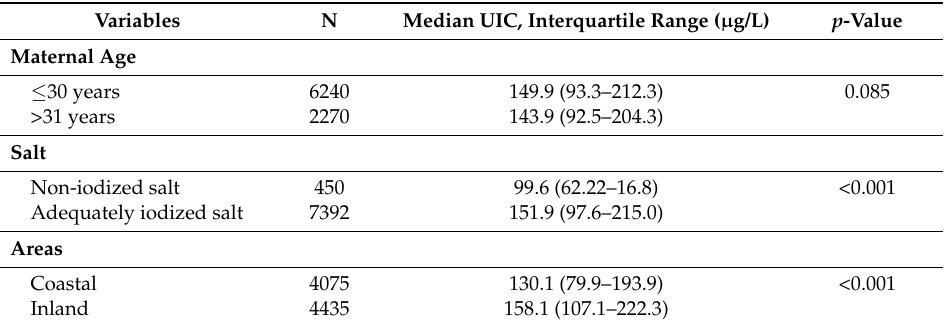
Table 3. Median UIC in pregnancy by maternal age, consuming salt, and areas.